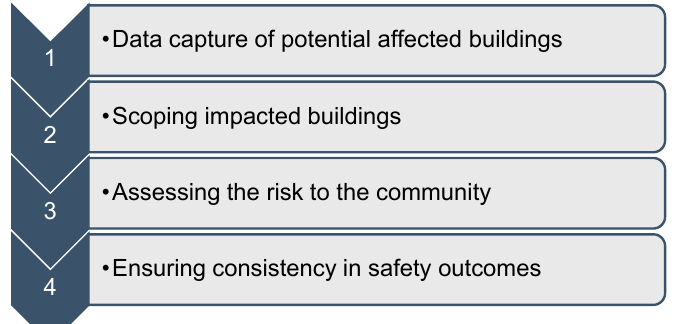
Figure 3. Four phase process for strengthening fire safety involving non-compliant building materials [16] .